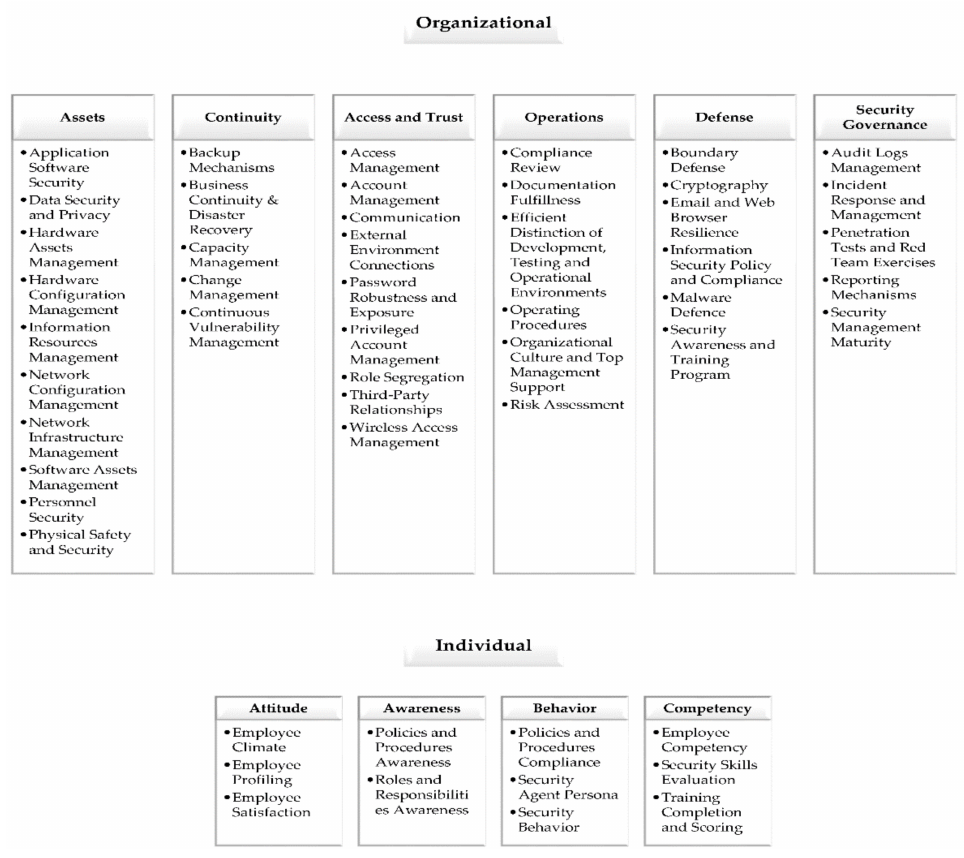
Figure 1. Cybersecurity Culture